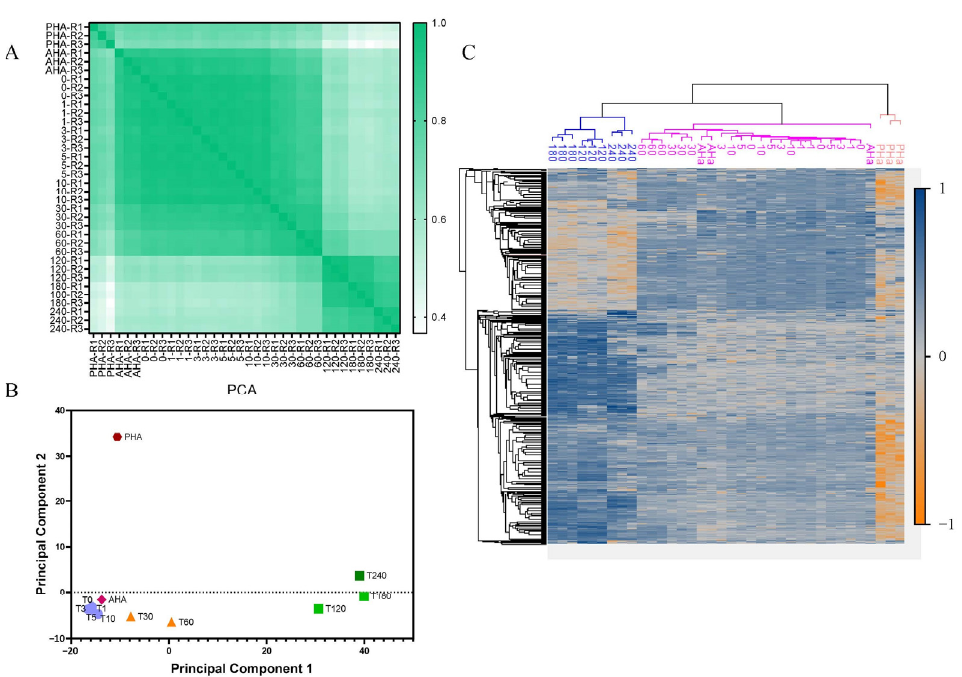
Figure 2. Comparison of the proteome at different time points during B. cereus spore germination and outgrowth. ( A ) Pairwise Pearson correlations between all replicates. ( B ) PCA score plot of germination at different time points. ( C ) Cluster heatmap of the proteome-wide analysis. The color represents the z-score transformed protein amounts of the LFQ intensity. Blue corresponds to an increased expression level, grey corresponds to an average level, orange corresponds to a decreased level, and columns and rows represent replicates at different time points and proteins, respectively. The time points are as follows: pre-heat activation (PHA), after heat activation (AHA), 0 min (T0, addition of germinants), 1 min (T1), 3 min (T3), 5 min (T5), 10 min (T10), 30 min (T30), 60 min (T60), 120 min (T120), 180 min (T180), and 240 min (T240).